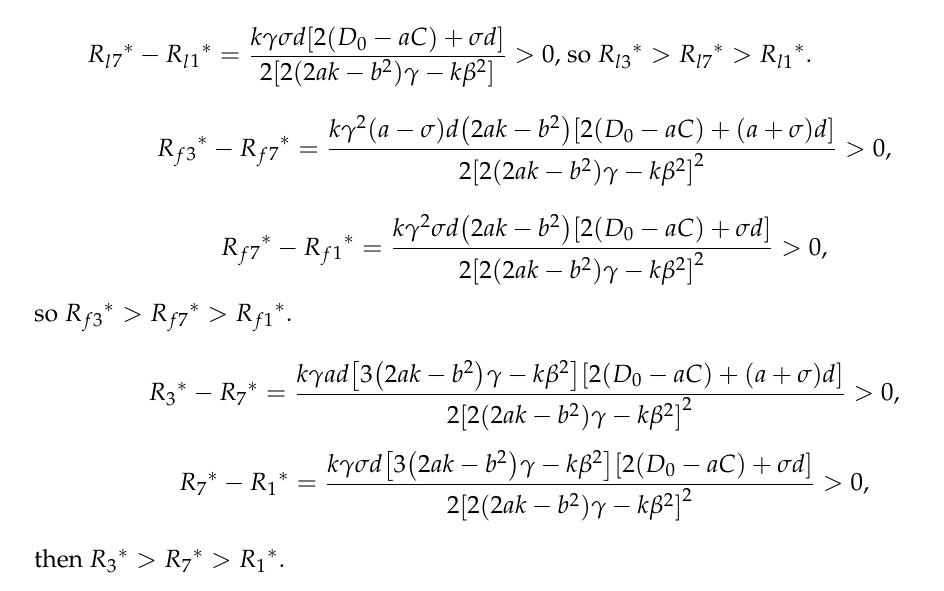
Table 5. Comparison of three strategies in decentralized